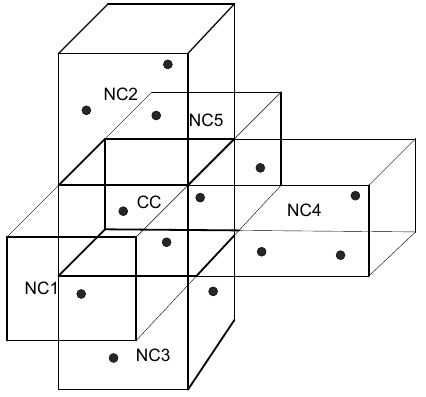
Figure 3. Cubical representation of target